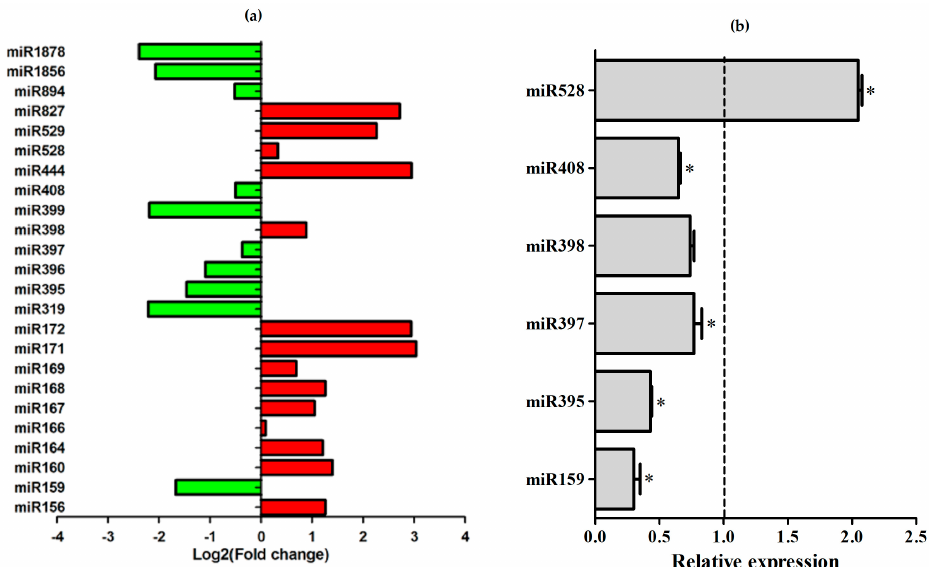
Figure 5. Expression analysis of the miRNAs in response to bacterial infection. ( a ) miRNA expression levels from bioinformatics analysis; ( b ) Validation of bioinformatics expression profiles of selected miRNAs by real-time PCR, using Rep 1 samples. The expression of six miRNAs was tested in mock-inoculated plants and Acidovorax avenae -infected plants. Dotted line represents the expression of the control samples. The error bars represent the standard deviation between three technical replicates. * represents significant changes of target expression between the control and inoculated samples ( p -value < 0.05).